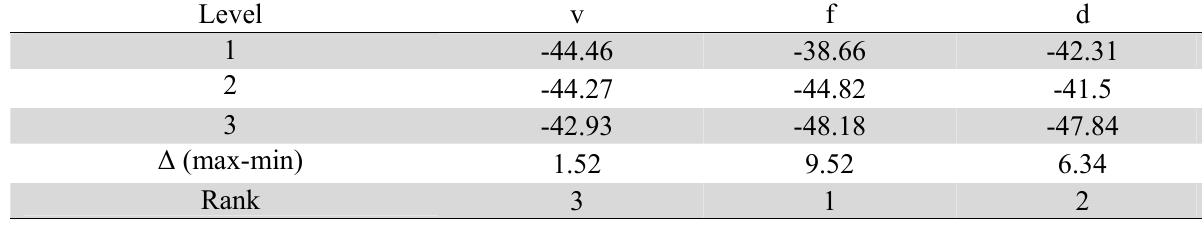
Response table of mean S/N ratio for cutting force